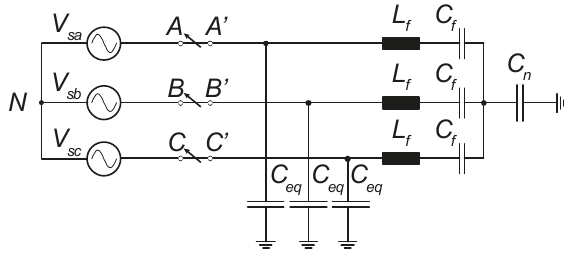
Figure 7. Equivalent circuit for the three-phase filter bank.